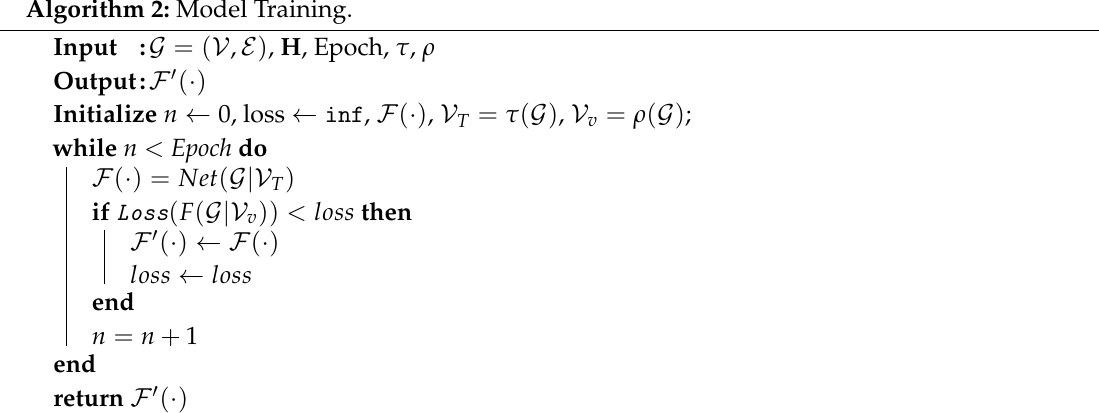
Algorithm 2: Model